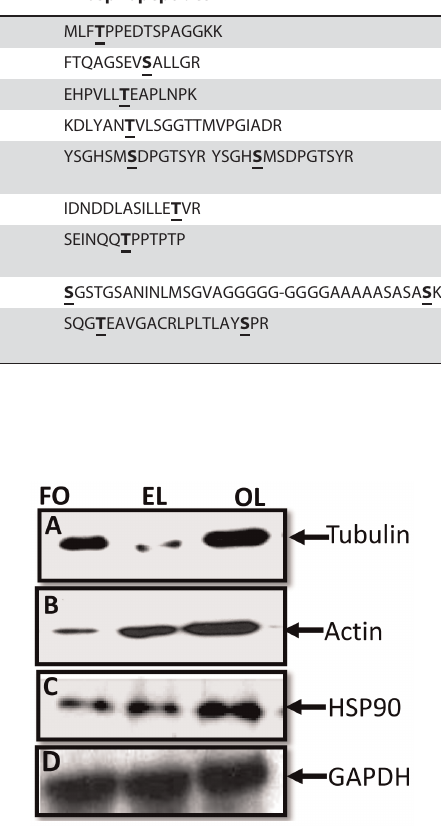
Figure 9. Western blot analysis of tubulin (A), actin (B) and HSP-90 (C) in Ova, early larvae (EL) and old larval (OL) stages of Neanthesarenaceodentata .